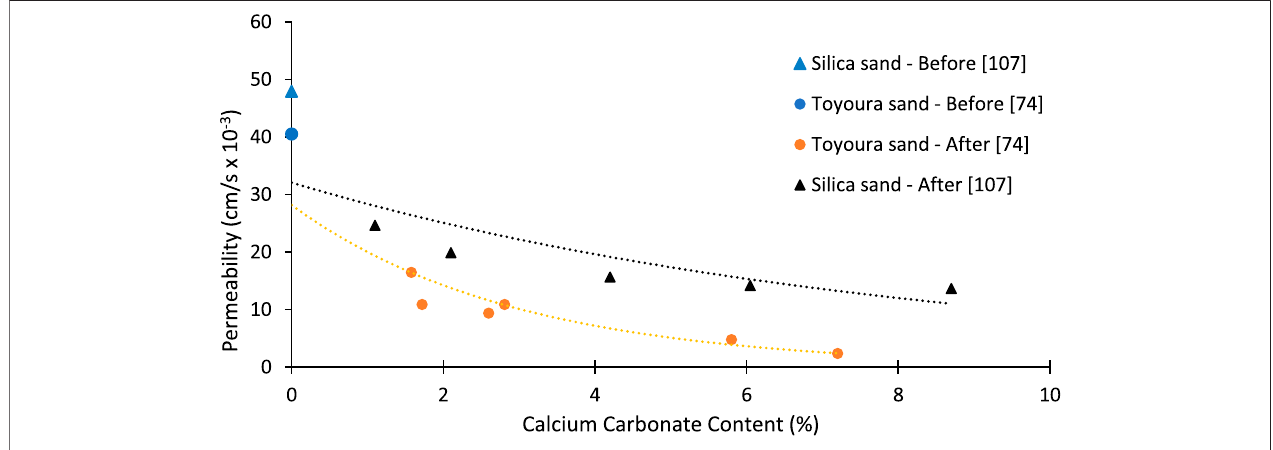
FIGURE 5 | Permeability reduction of Toyoura sand and Silica sand [Data sourced from (Yasuhara et al., 2012; Putra et al., 2017b)].